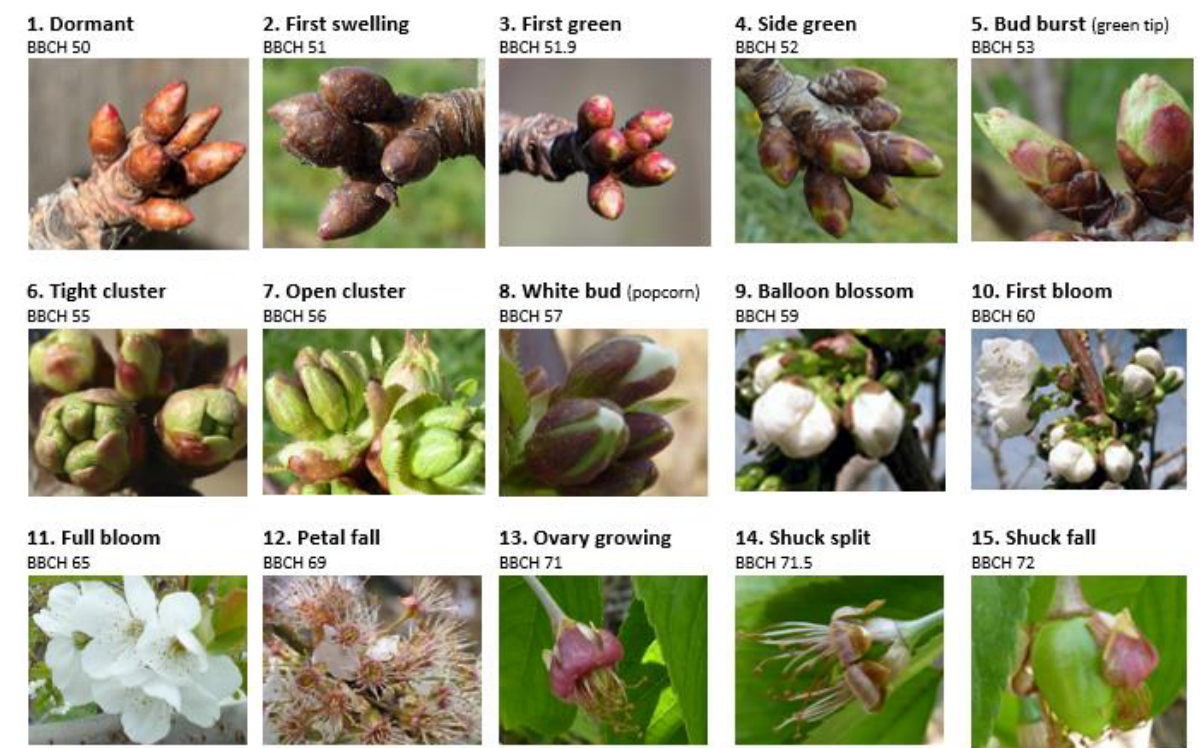
Figure 1. Phenological stages in sweet cherry with reference to the BBCH growth stages [33,34]. Photo credits: SA Bound.